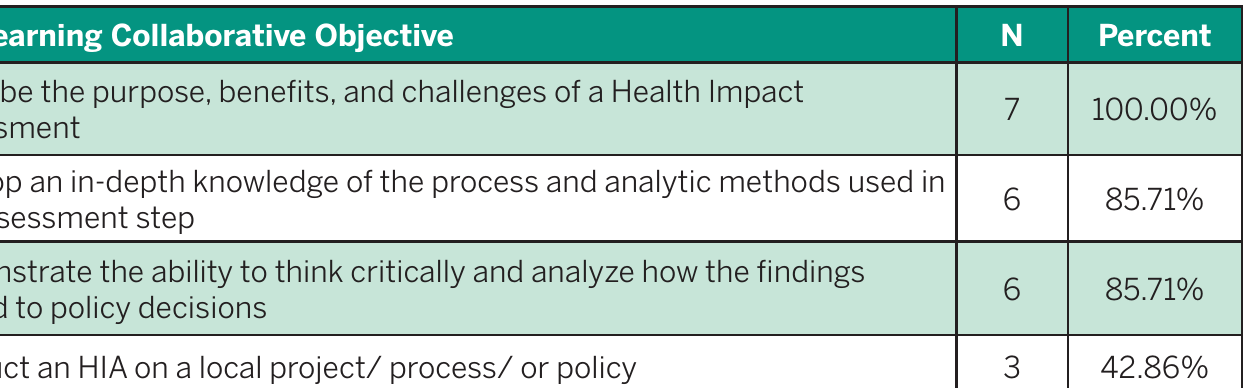
Table 1: Number and percentage of respondents who felt that the HIA Learning Collaborative objectives were